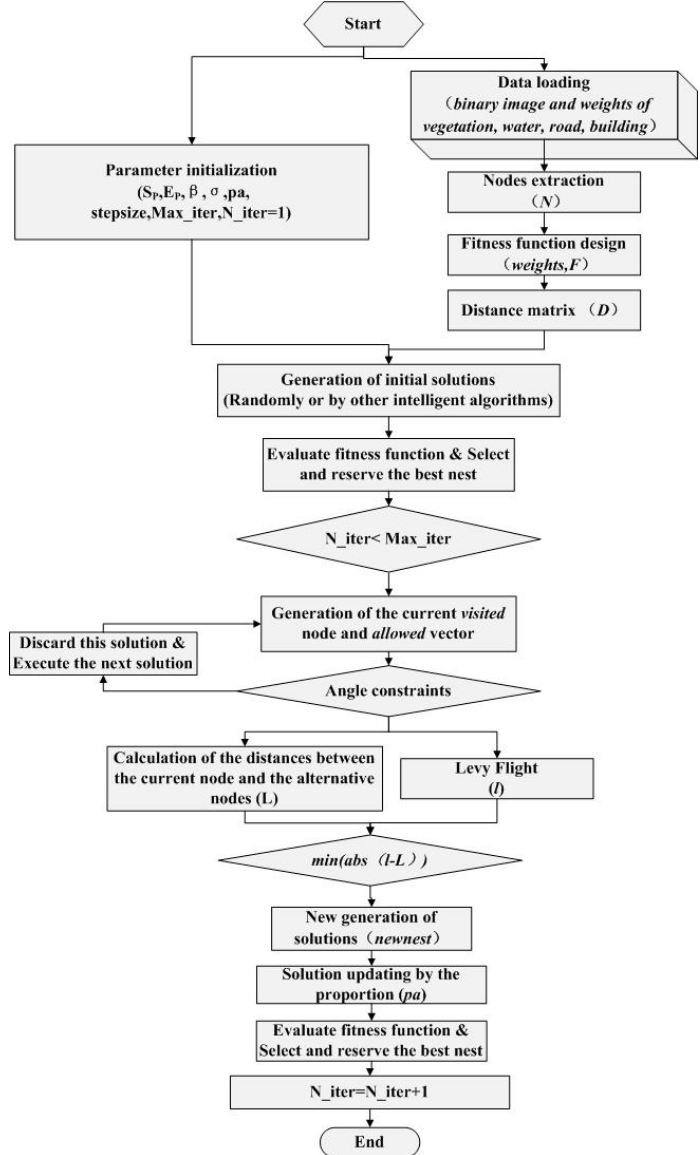
Figure 8. Flowchart of the modified CS.